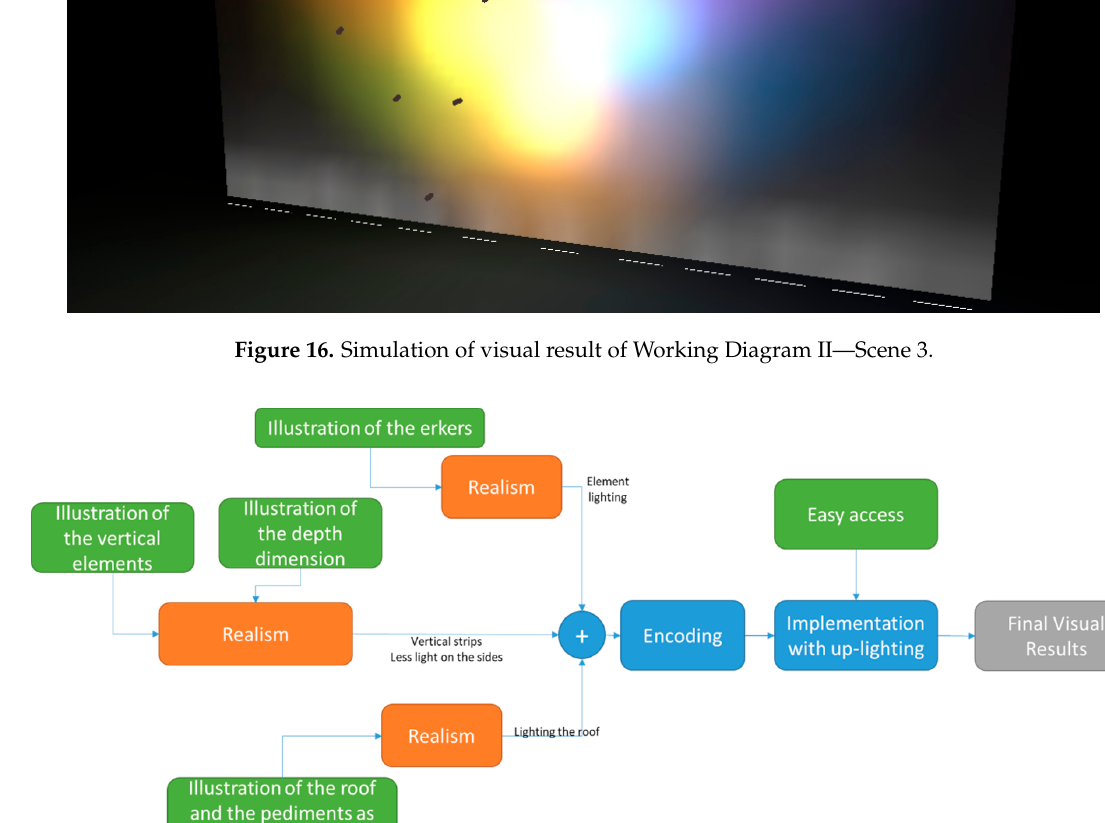
Figure 17. Working Diagram III, depicting a concept with lighting.